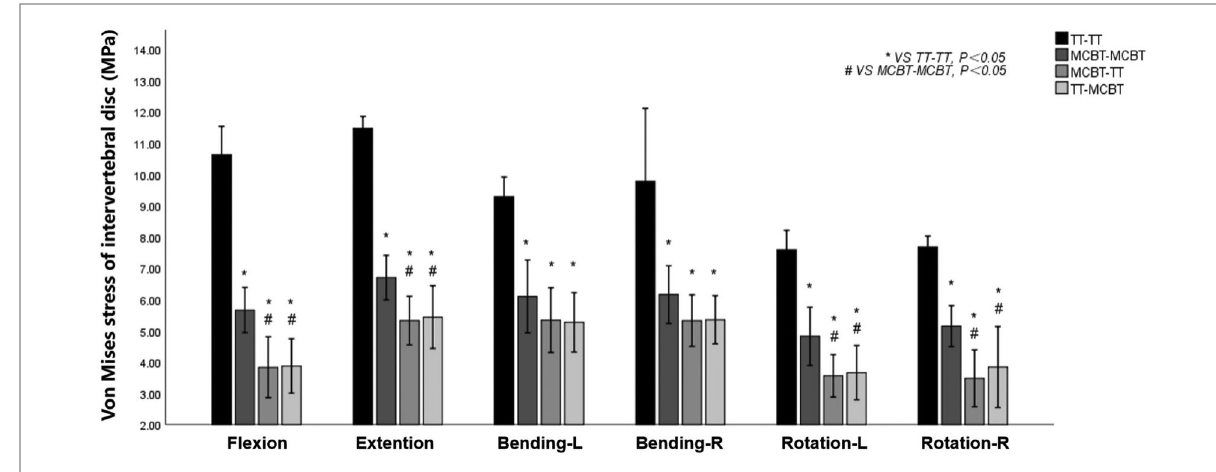
FIGURE 5 Mean values and minimum – maximum ranges of disc stresses at the fi xation segment in four fi xation models.